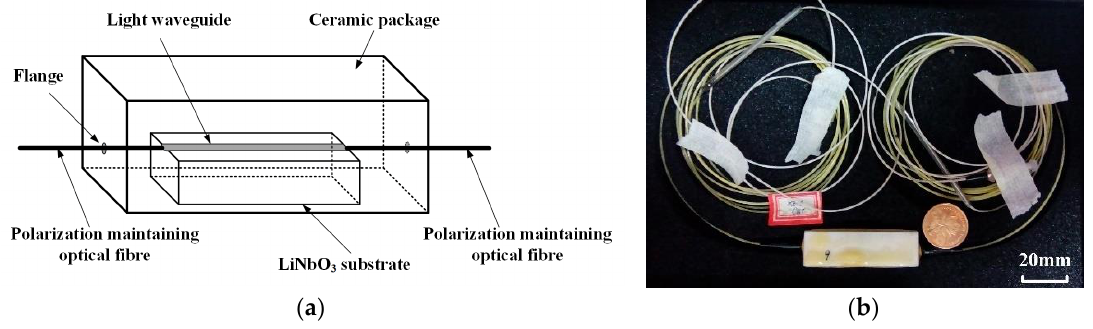
Figure 2. Integrated optical electric-field sensor. ( a ) schematic diagram; ( b ) product photo.